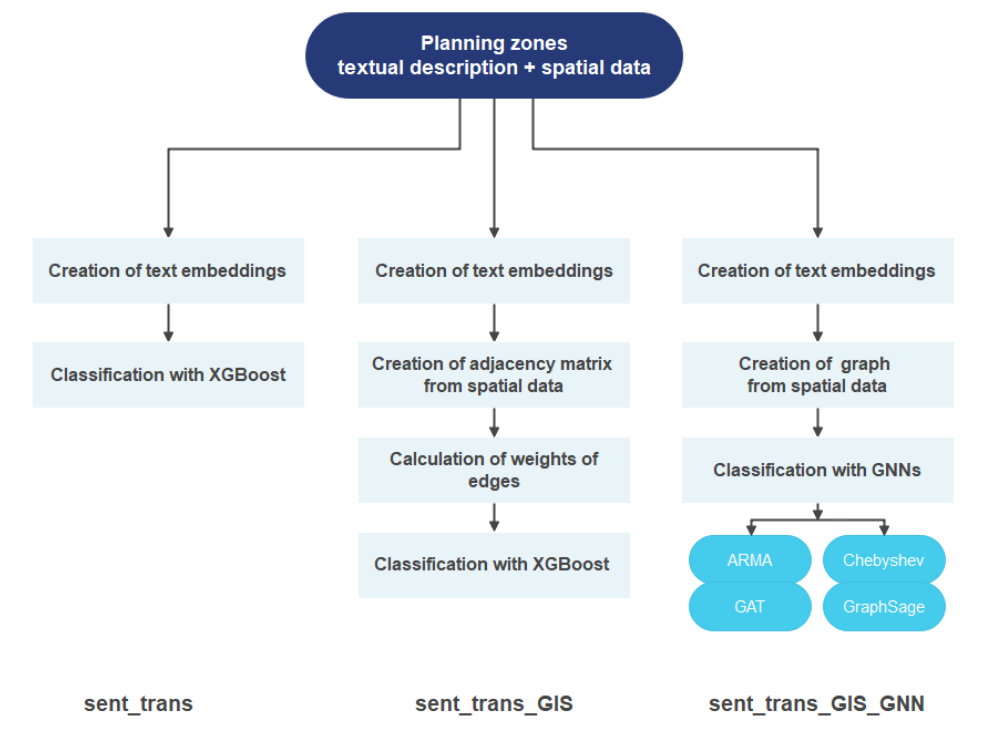
Figure 3. Flowchart of the proposed